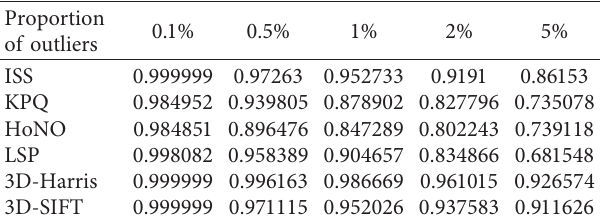
Table 12: The outlier repetition rate r tection algorithm on the space time data set.